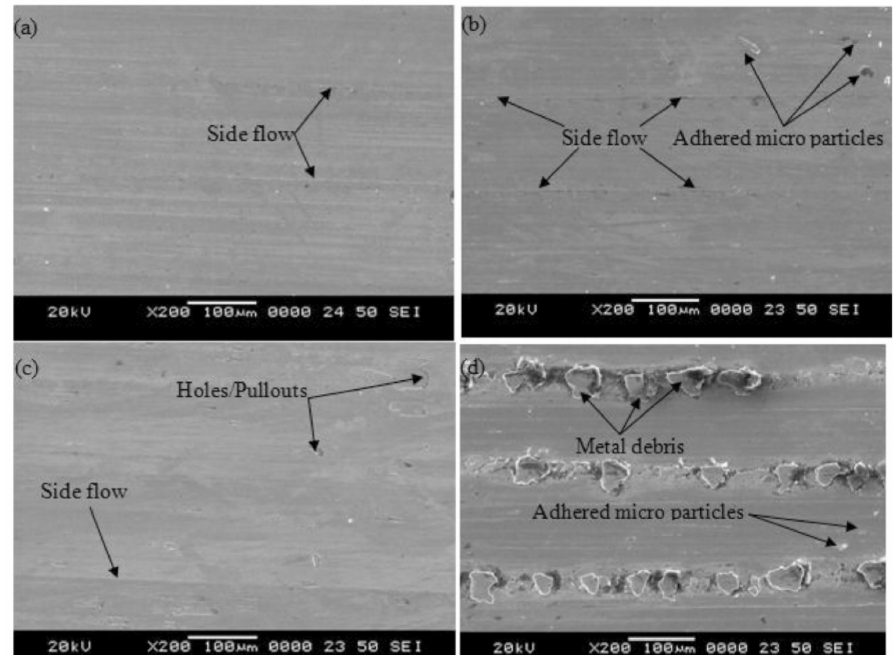
Figure 15. Images of surface morphology under different cooling environments. ( a ) cryogenic, ( b ) wet, ( c ) MQL, ( d ) dry, reprinted with permission from ref. [78]. Copyright 2018